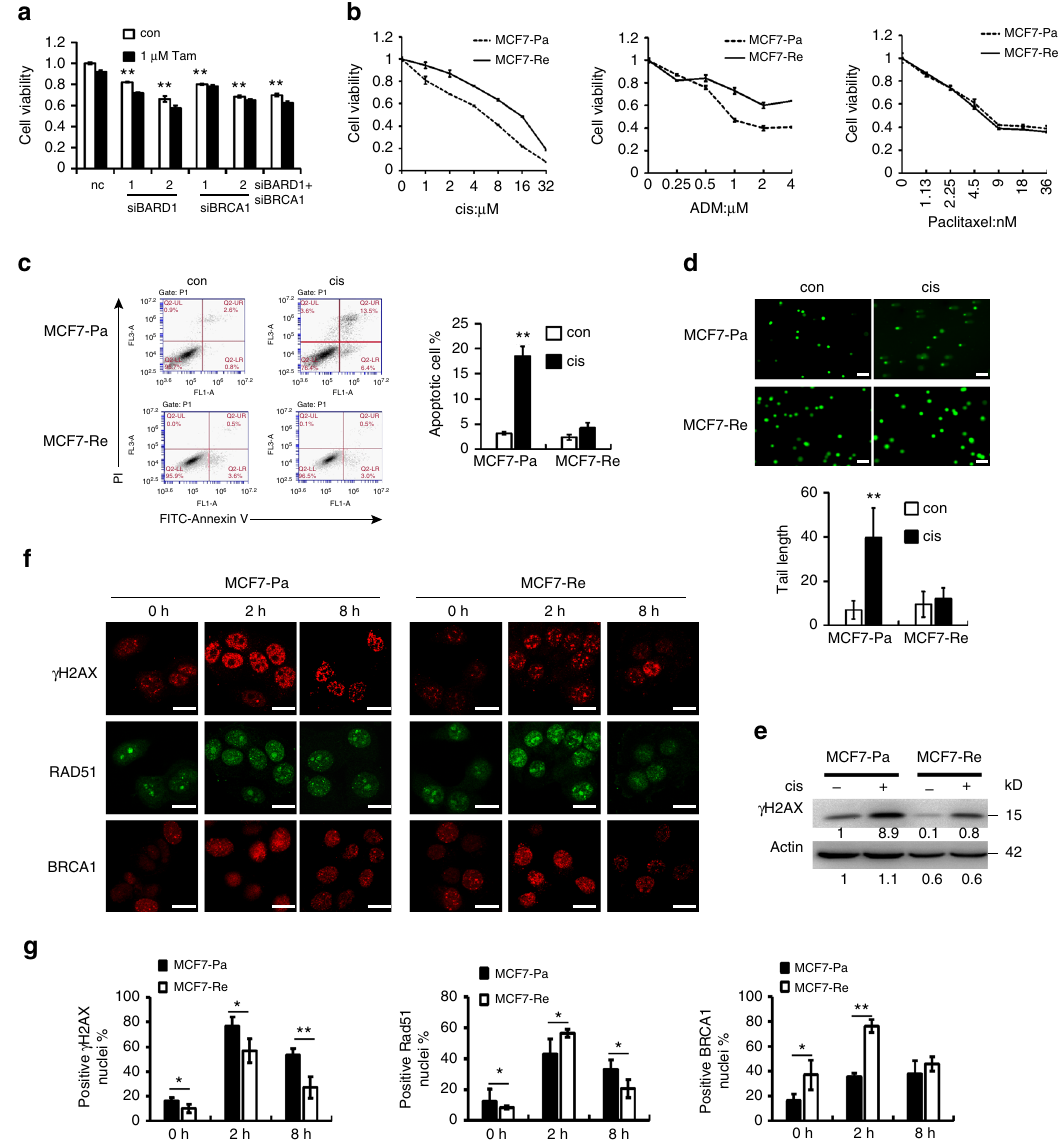
Fig. 2 Tamoxifen-resistant cells are resistant to DNA-damaging chemotherapy. a Cell viability assay showing the effect of tamoxifen on MCF7-Re cells when transfected with negative control siRNA (nc), BARD1, and/or BRCA1 siRNAs. b MCF7-Pa and MCF7-Re cells were treated with different concentrations of cisplatin (cis), adriamycin (ADM), or paclitaxel, and the proportions of viable cells were examined by cell viability assay. c Apoptosis assay by AnnexinV-FITC/PI staining showing the percentages of apoptotic cells when MCF7-Pa and MCF7-Re cells were treated with cisplatin. d Comet assay showing the DNA damage when MCF7-Pa and MCF7-Re cells were treated with cisplatin. Scale bar indicated 100 μ m. e Western blot showing the expression of γ H2AX when MCF7-Pa and MCF7-Re cells were treated with cisplatin. f Representative immuno fl uorescence staining of γ H2AX, Rad51, and BRCA1 in MCF7-Pa and MCF7-Re cells treated with cisplatin at 0 h, 2 h, 8 h. Scale bar indicated 25 μ m. g Percentages of positive nuclei (10 foci or more per nucleus being considered positive) from three fi elds per sample are indicated. In a – d , g , data show means ± s.d. ( n = 3) * p < 0.05; ** p < 0.01; compared with control or indicated lines by Student ’ s t